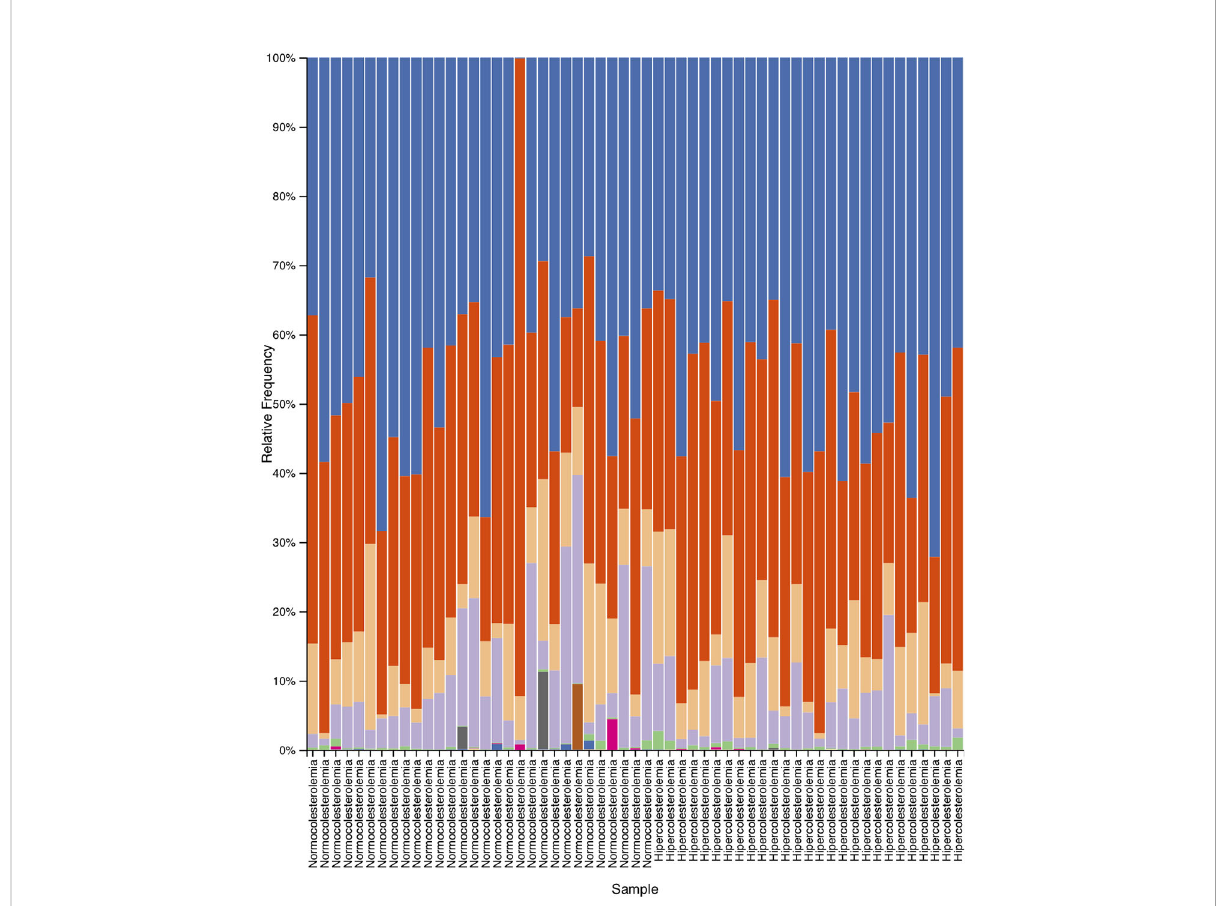
FIGURE 2 Relative abundance obtained by taxonomic analysis with Quantitative Insights Into Microbial Ecology 2 (QIIME2), which indicate the different phylum present in the deposition samples of hypercholesterolemic individuals and controls.